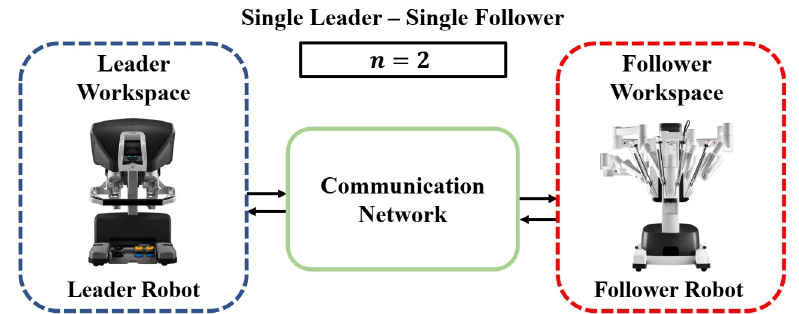
Figure 4. Single-leader–single-follower topology where n is the number of network ports/terminals (Images ©2020 Intuitive Surgical, Inc., Sunnyvale, CA,